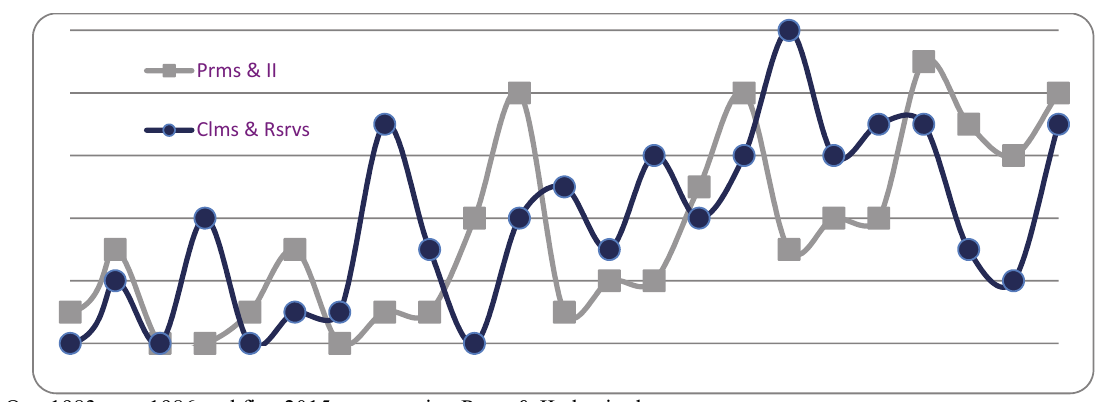
Fig. 8. Number of Life Insurance Efficiency Studies Using Different Output Proxy Sets With no Author Duplication (Year-by-Year)